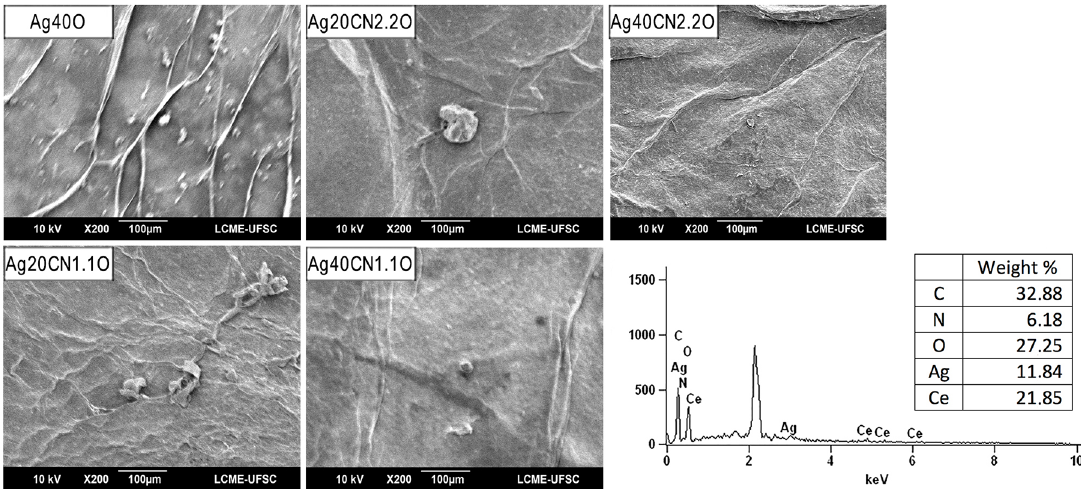
Figure 8. Micrographs obtained by scanning electron microscopy of the upper surface of the functionalized BC membranes submitted to a thermal treatment in oven, and EDS analysis of sample Ag40CN2.1O.